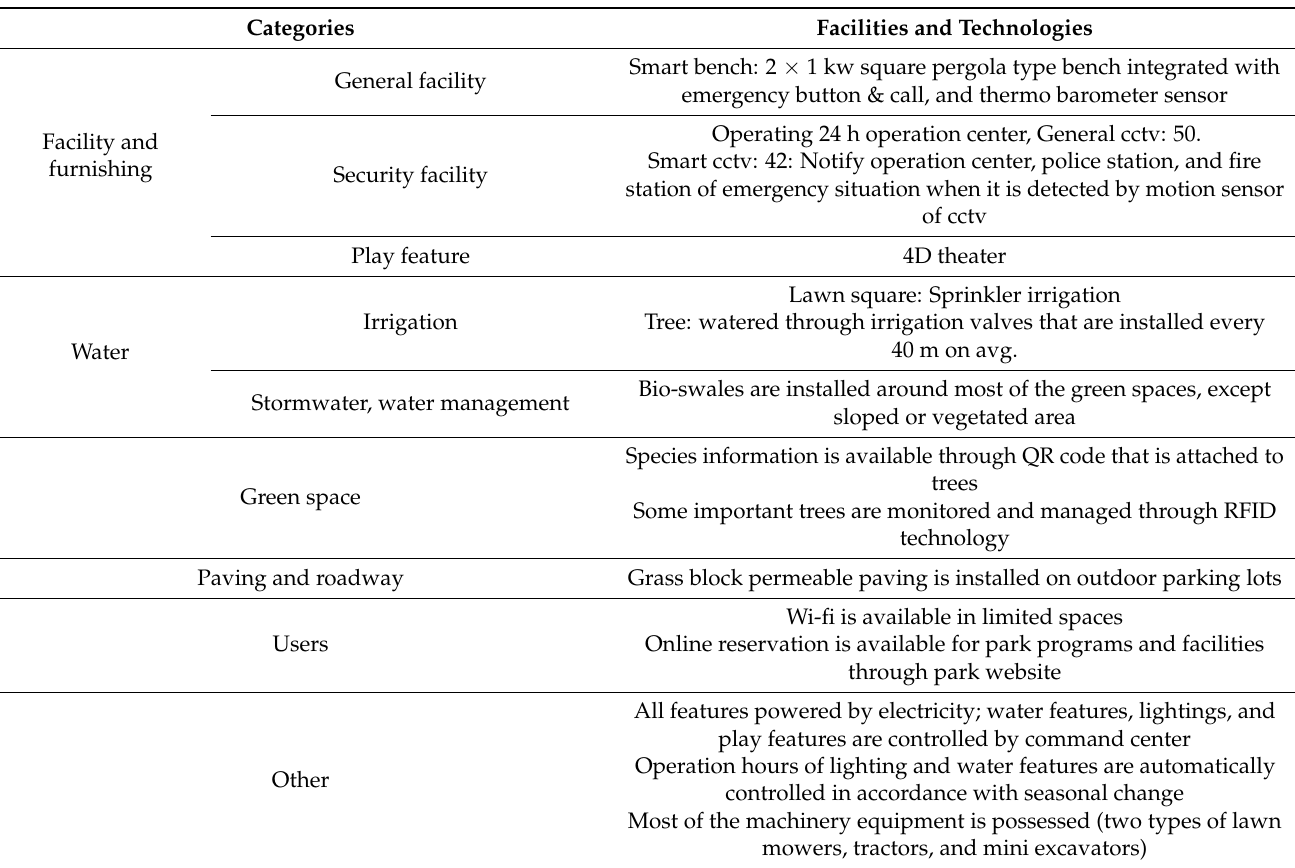
Table 4. The current use of smart facilities and technologies applied to the